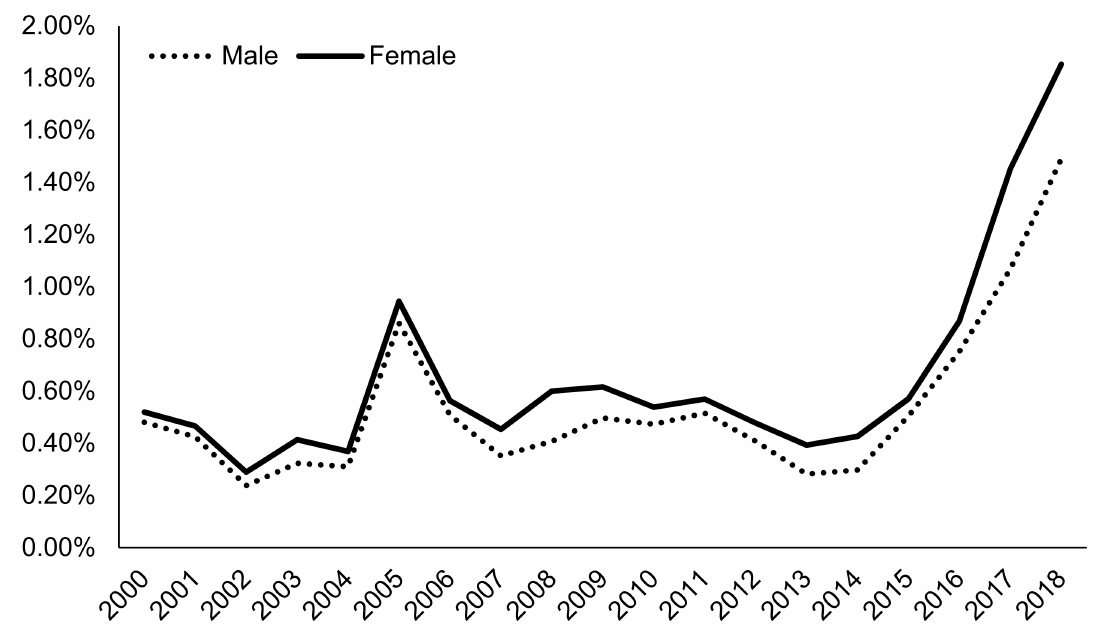
Figure 2. Prevalence of naltrexone treatment prescribed in alcohol use disorder (AUD) admissions from 2000–2018 by gender using TEDS-A data. Temporal trends were significant by the Cochran–Armitage trend test ( p <